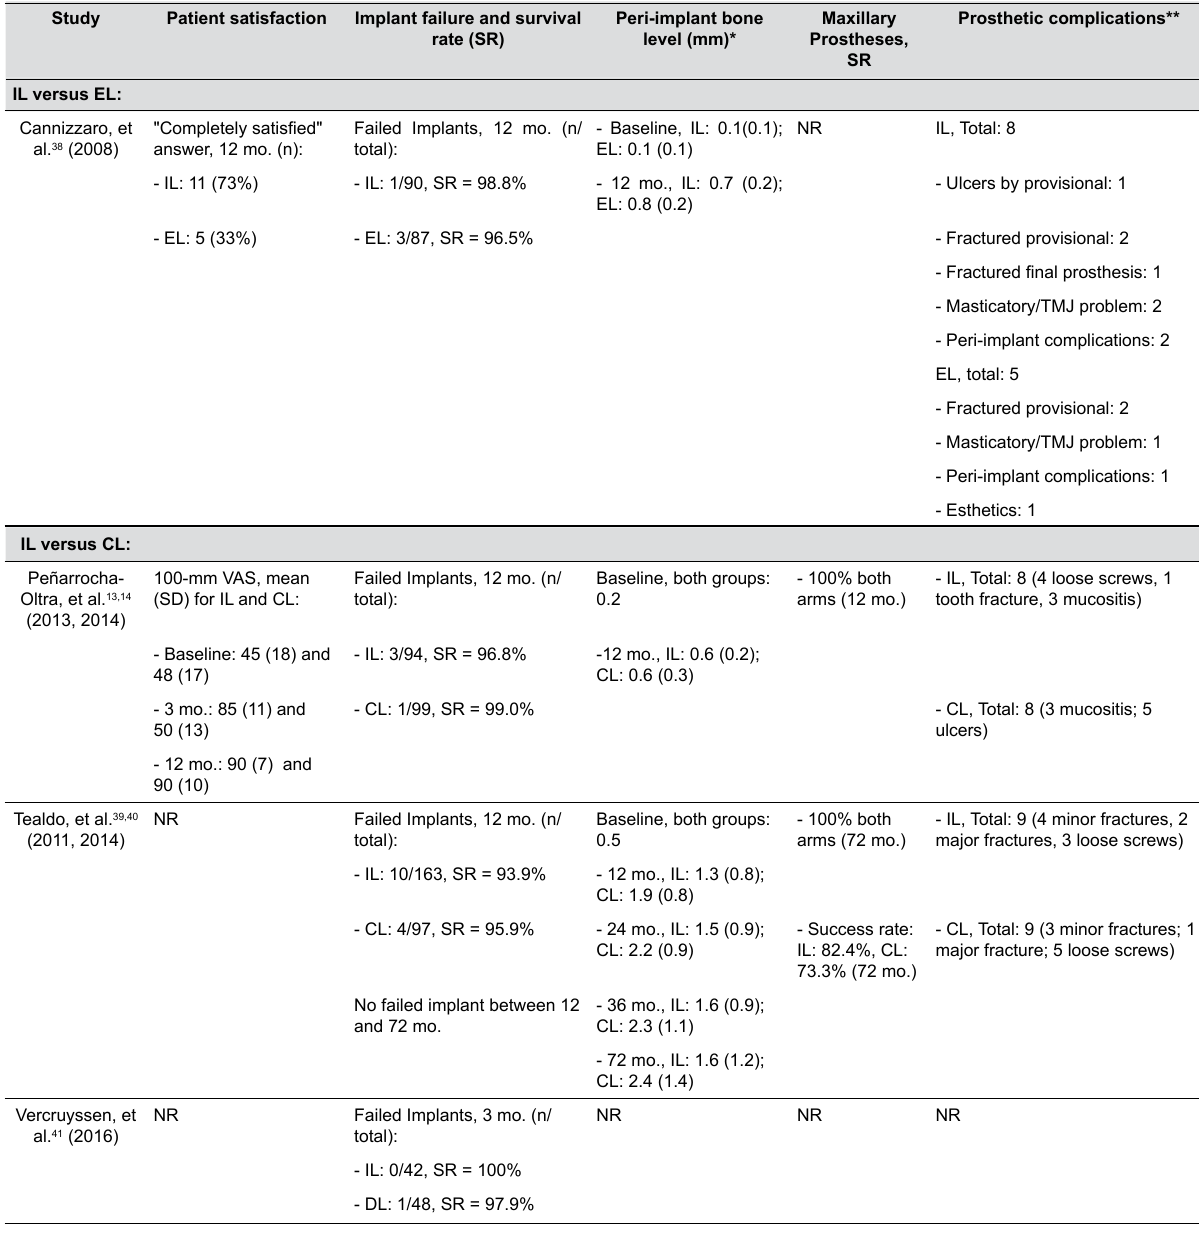
Table 2- Summary of outcome data from included studies (NR: not